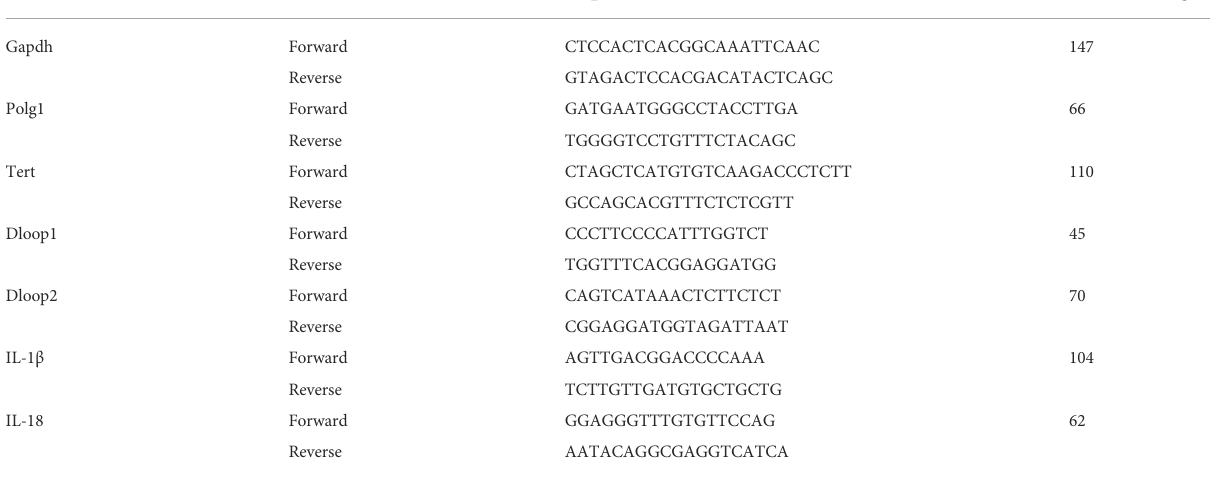
TABLE 3 Primer sequence.